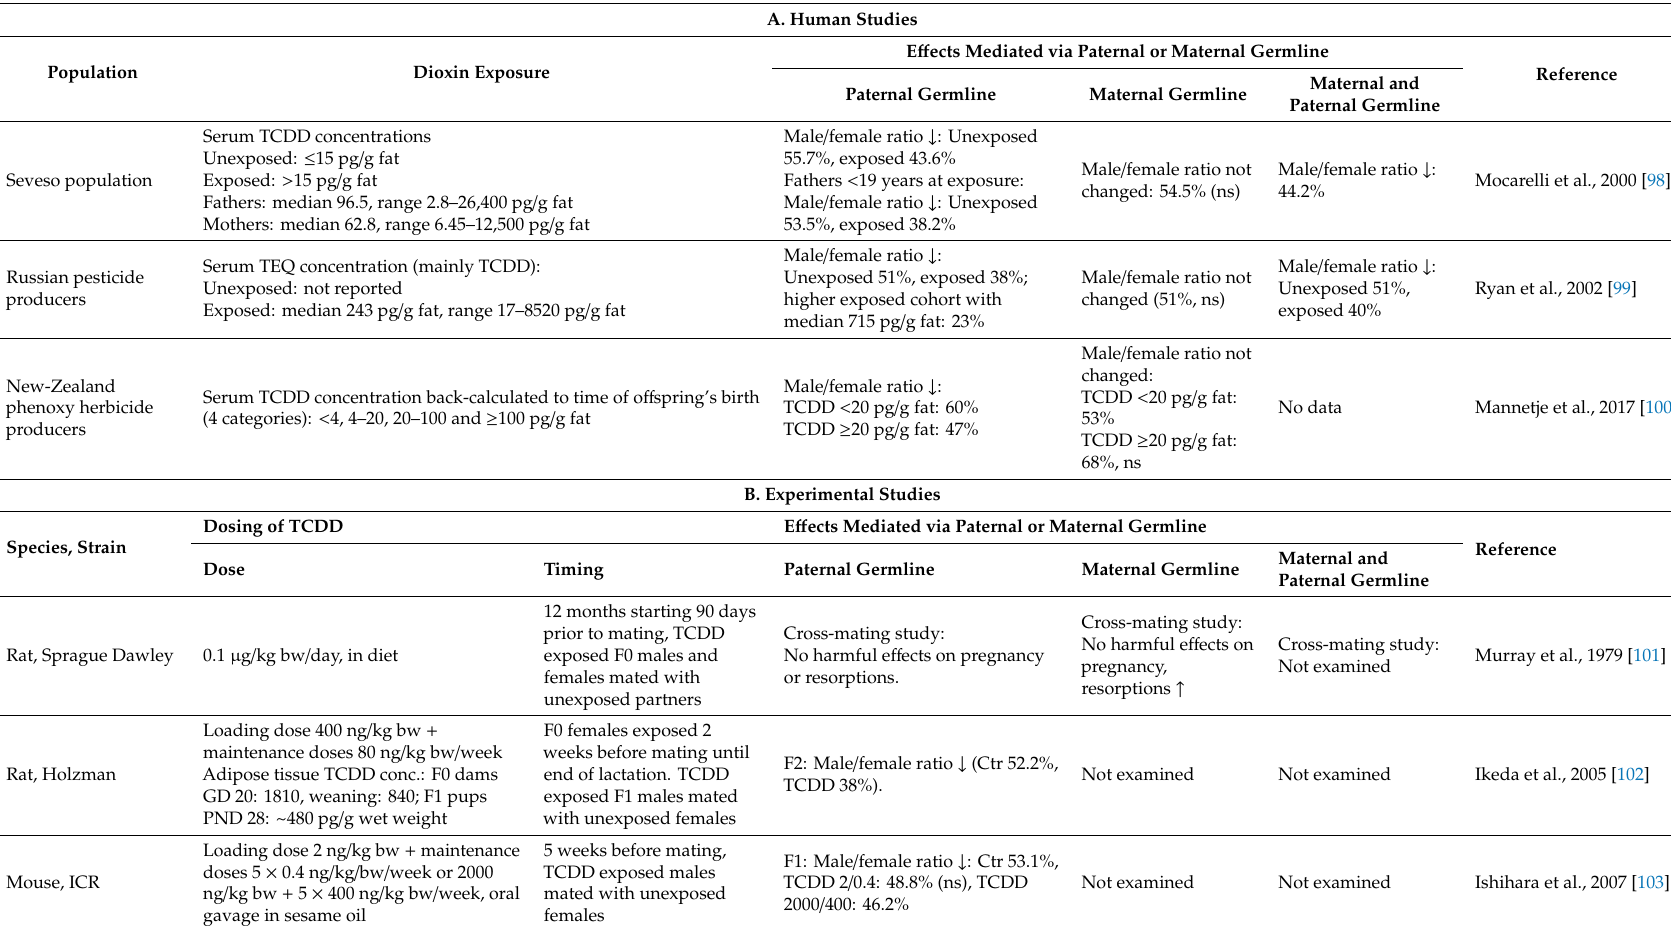
Table 1. Summary of human and experimental studies with a focus on paternally (versus maternally) mediated e ff ects of dioxins on the next generation o ff spring. Reported changes statistically significant unless indicated nonsignificant